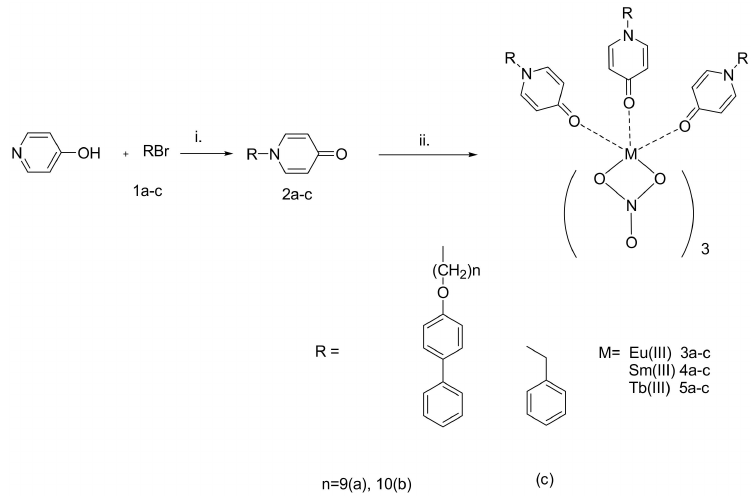
Scheme 1. Synthetic protocol for the preparation of 4-pyridone ligands and the corresponding